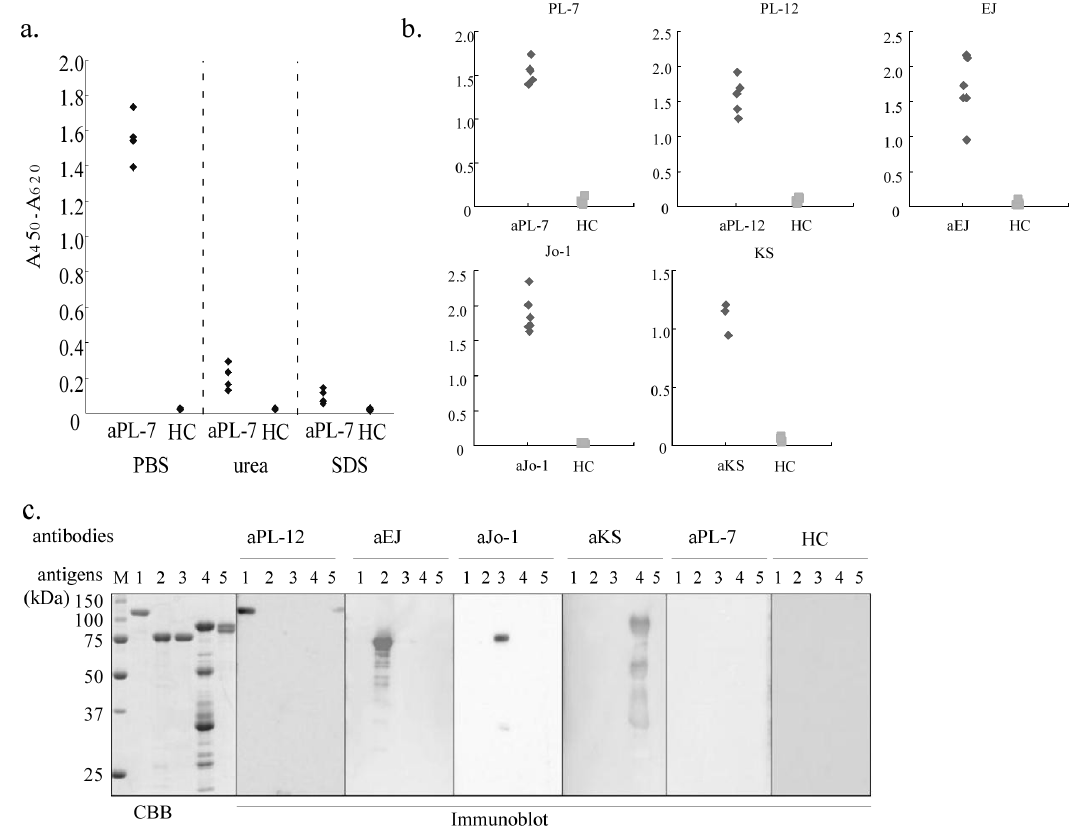
Figure 1. Antigenic activity of recombinant autoantigens a. Antigenic activity of PL-7 in various conditions. Left, purified recombinant PL-7 was eluted and diluted in PBS and coated on ELISA plates. Middle and Right, purified recombinant PL-7 was eluted in PBS and diluted in 8M urea and 2 6 SDS sample buffer, respectively, and then coated onto ELISA plates. b. Five recombinant ARS antigens (His-PL-12, His-EJ, GST-Jo-1, GST-KS, and His-PL-7) were prepared as soluble polypeptides in PBS and their antigenic activity was tested in an ELISA using sera from five patients each containing corresponding autoantibodies (only GST-KS was tested using sera from three patients). Six healthy controls were used in each ELISA. c. Purified recombinant ARS antigens were electrophoresed on SDS-PAGE and transferred to a PVDF membrane followed by immunoblot analysis. CBB; Coomassie Brilliant Blue staining of gels, M; molecular weight marker, HC; healthy control, Lane 1; His-PL-12, Lane 2; His-EJ, Lane 3; GST-Jo-1, Lane 4; GST-KS and Lane 5; His-PL-7. doi:10.1371/journal.pone.0085062.g001 not shown). There were seven anti-ARS-positive patients with Clinical significance of anti-ARS ELISA in IIP other CTDs; two SSc patients were positive for anti-PL-12, two SLE patients were positive for anti-KS or anti-PL-12, and three RA patients were positive for anti-KS, anti-OJ or anti-PL-12.